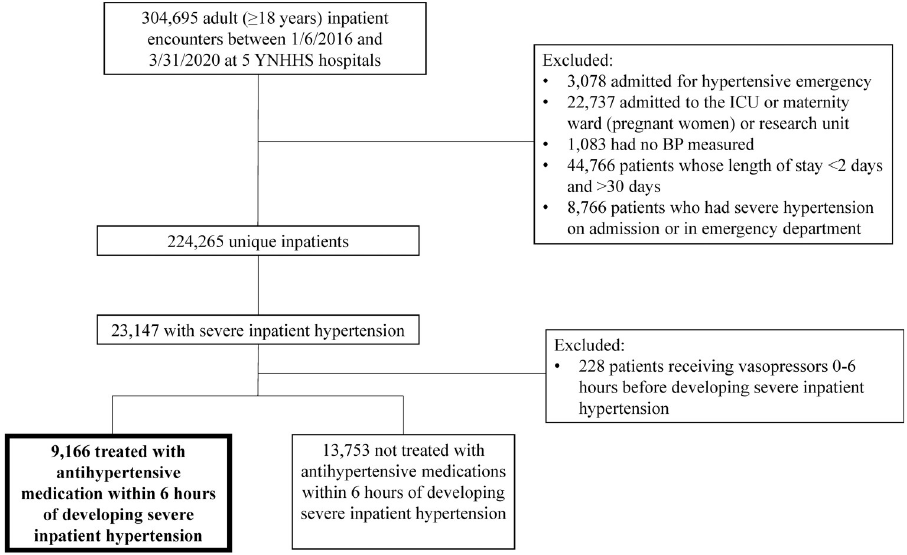
Fig 1. Study flow diagram. YNHHS: Yale New Haven Health System; ICU: intensive care unit; BP: blood